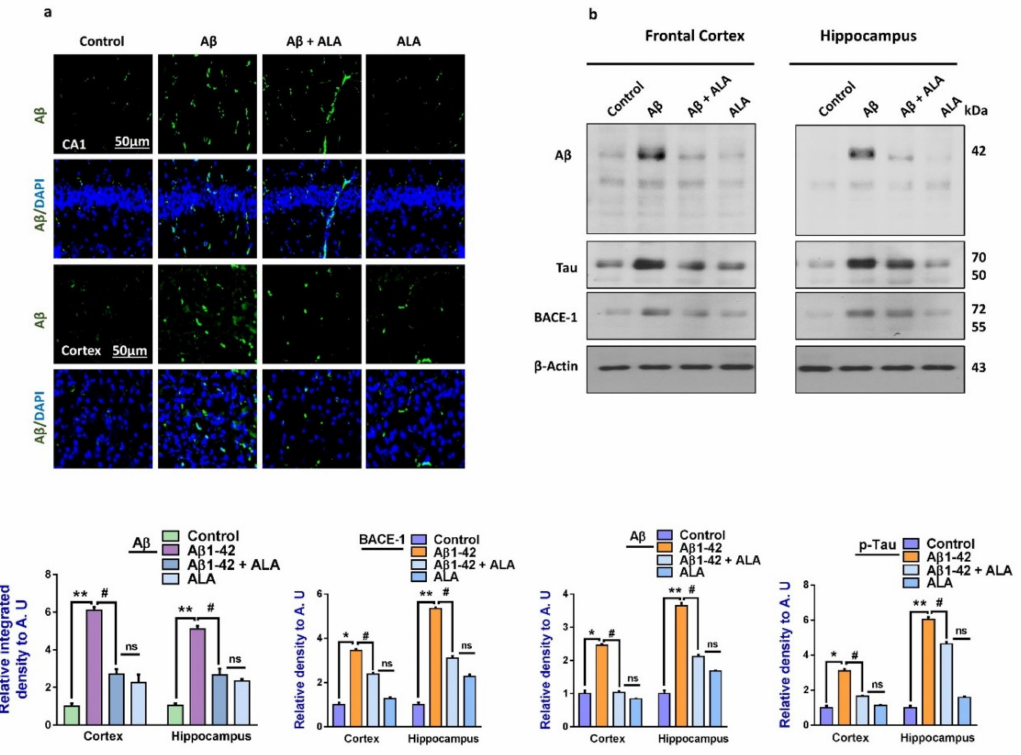
Figure 4. E ff ects of alpha linoleic acid against A β -induced AD-like changes in the mouse brains. ( a ) Immunofluorescence results of A β in the frontal cortex and hippocampus of the experimental groups ( n = 16 mice per group, 8 for IF and 8 for WB), with their respective bar graphs, magnification 30 × , scale bar 50 µ m. ( b ) Immunoblots results of A β , BACE-1, and p-Tau in the frontal cortex and hippocampus (CA1) of the treated mice groups ( n = 10 mice per group), with respective bar graphs. * Significantly di ff erent from the A β -treated group; # significantly di ff erent from the A β + ALA-cotreated group. Significance = * p < 0.05; * * p < 0.01; # p < 0.05; and ## p < 0.01. A β : amyloid beta; ALA: alpha linoleic acid; DAPI: 4 (cid:48) ,6-diamidino-2-phenylindole; ns = non